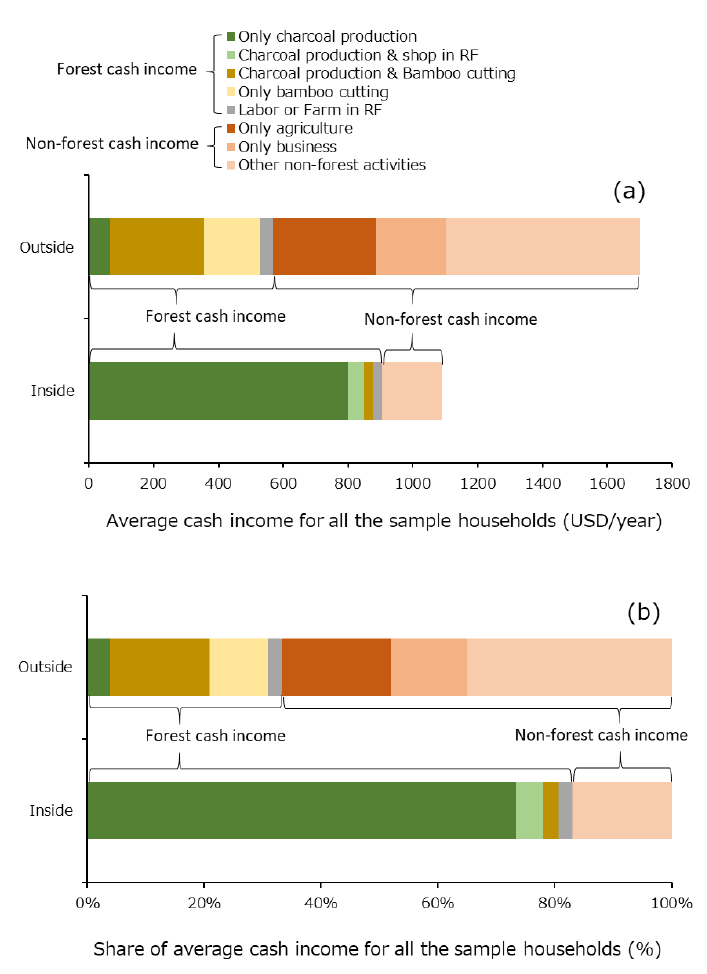
Figure 4. Average total cash income for all the sample households with being classified into 5 forest cash income and 3 non-forest cash income sources. The units are ( a ) USD / year and ( b ) share (%) of average income.